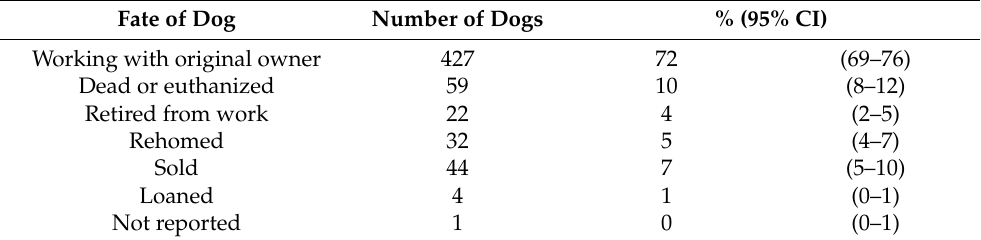
Table 3. The fates of 589 working farm dogs enrolled in TeamMate.